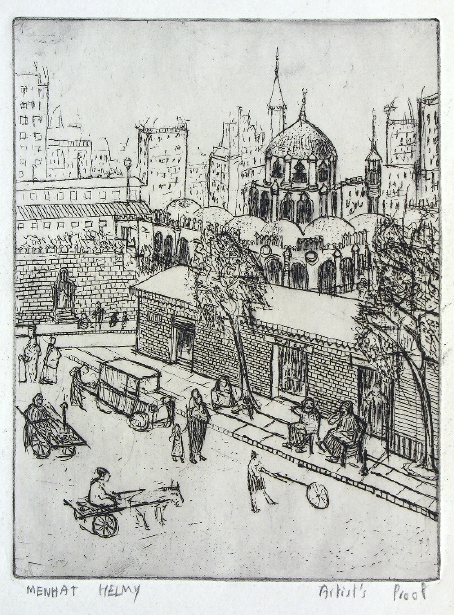
Figure 18. Menhat Helmy, A Mosque in Bulaq. Artist’s Proof. 1956. Etching on zinc. 16.5 × 21 cm.